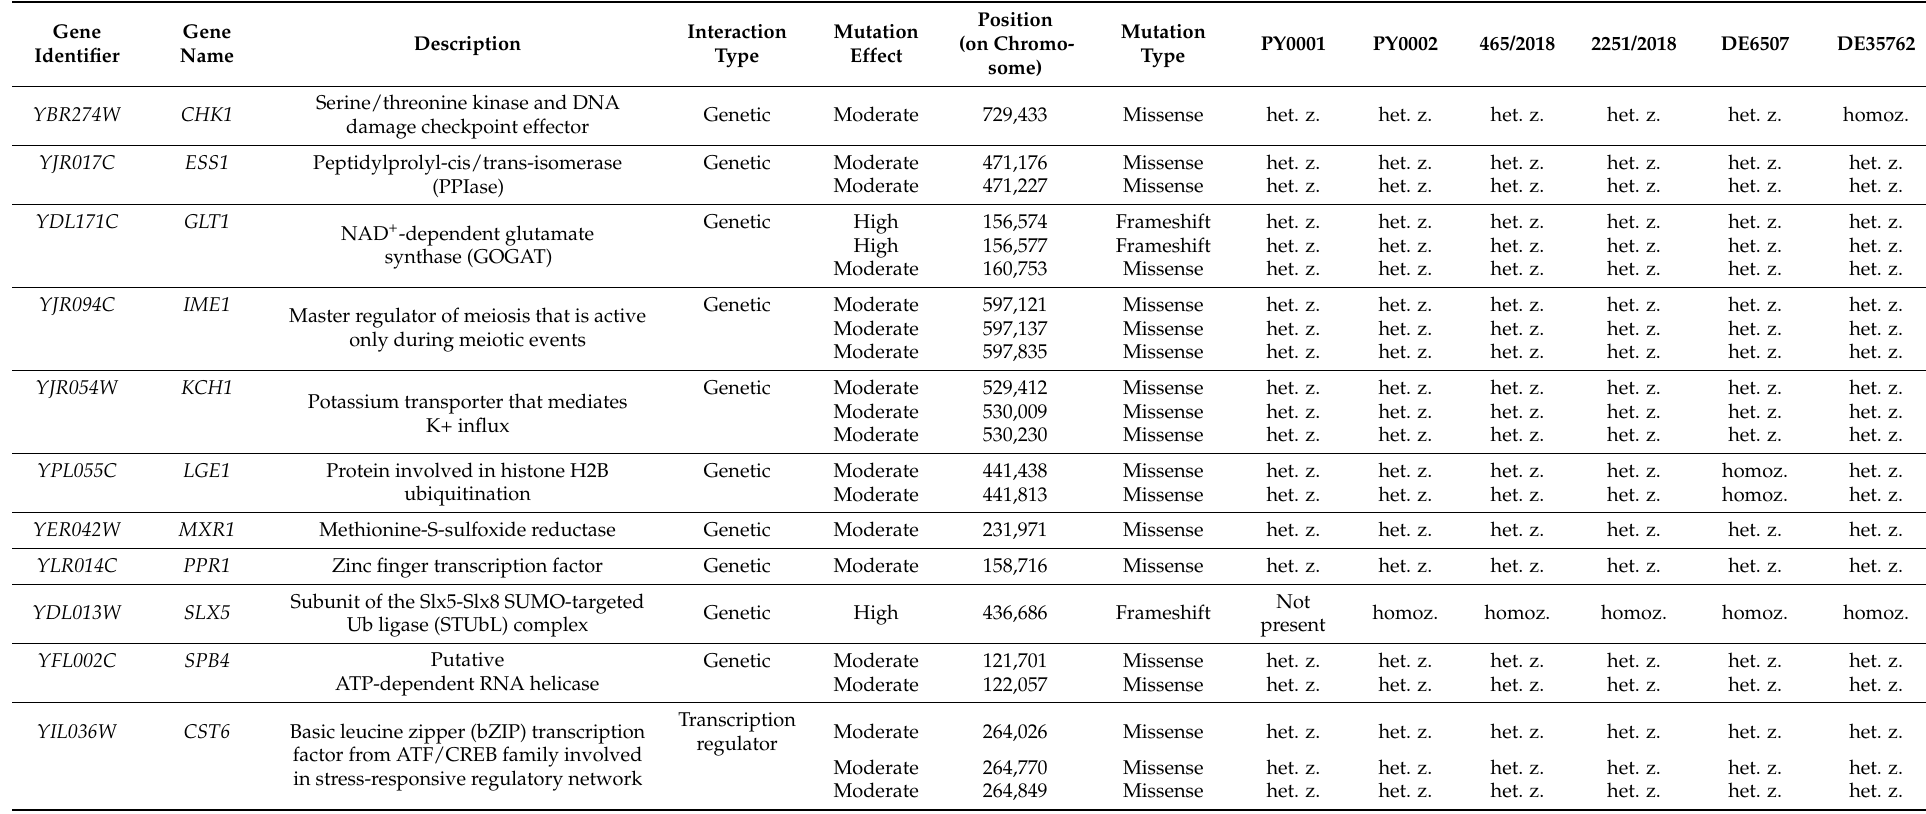
Table 3. List of mutations affecting genes with known interactions with HMX1 in the six sequenced isolates. Mutations in each interacting gene are listed for all six studied genomes, heterozygous ones are marked with “het. z.”, homozygous ones with